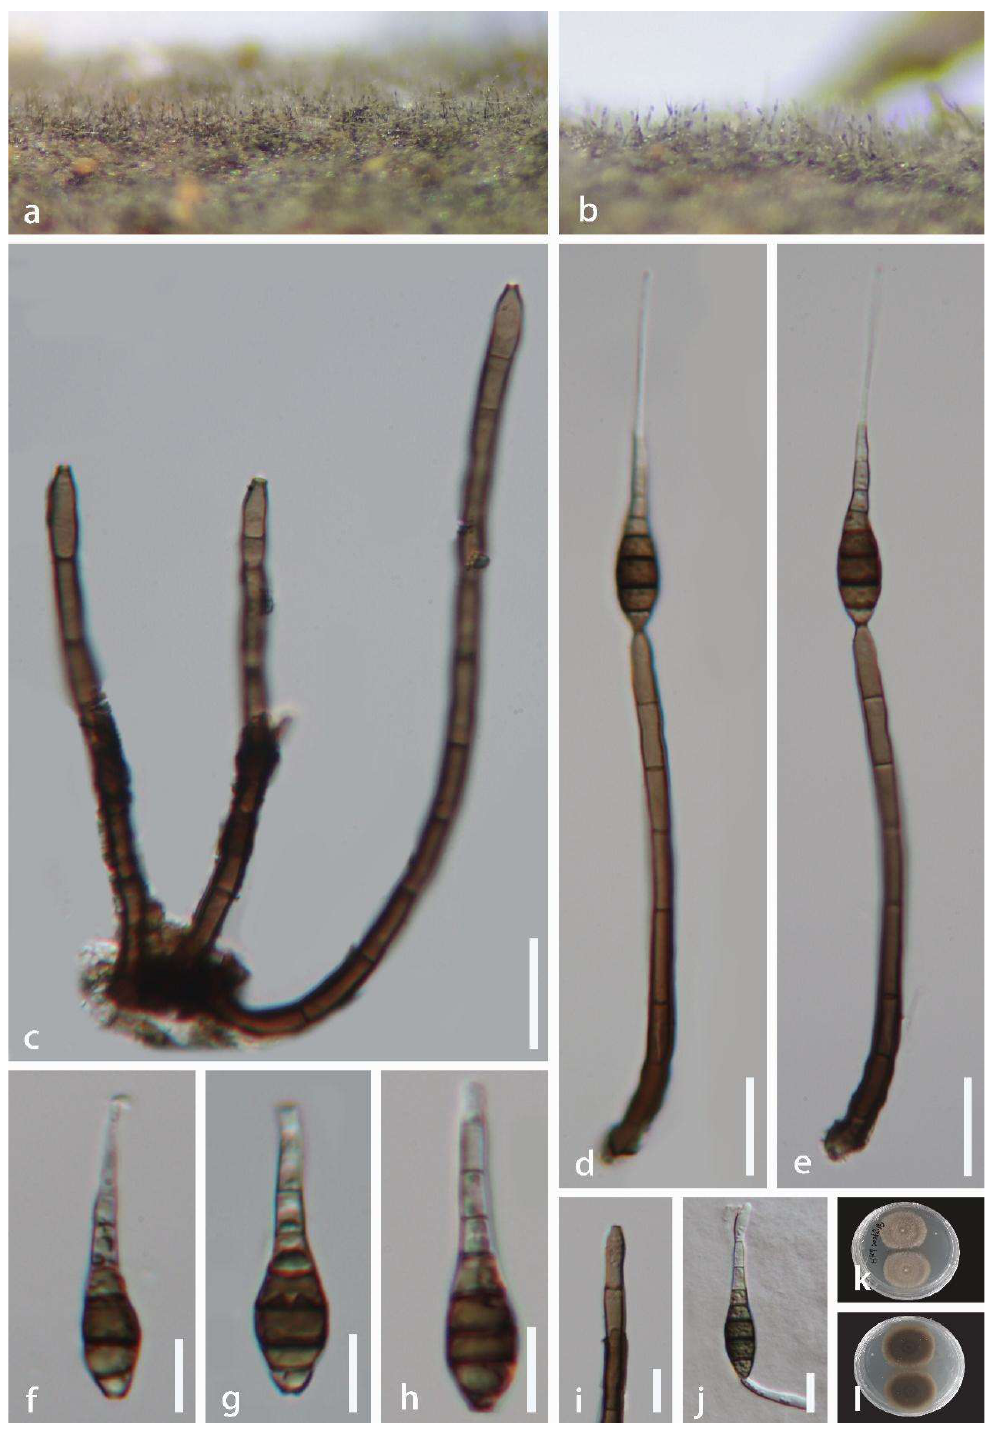
Figure 7. Distoseptispora tropica (HKAS 123761, holotype). ( a , b ) Colonies on the host surface. ( c ) Conidiophores and conidiogenous cells. ( d , e ) Conidiophores with attached conidia. ( f – h ) Conidia. ( i ) Conidiogenous cell. ( j ) Germinating conidium. ( k , l ) Colonies on PDA, k from above, l from reverse. Scale bars: ( c – e ) 20 μm, ( f – j ) 10 μm. Distoseptispora wuzhishanensis J. Ma and Y.Z. Lu, sp. nov., Figure 8. Index Fungorum number: IF559706; Facesoffungi number: FoF11336.